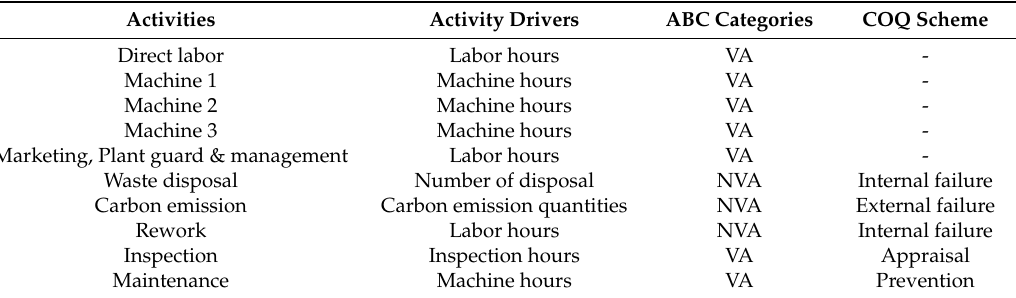
Table 1. Activity analysis in accordance with COQ and